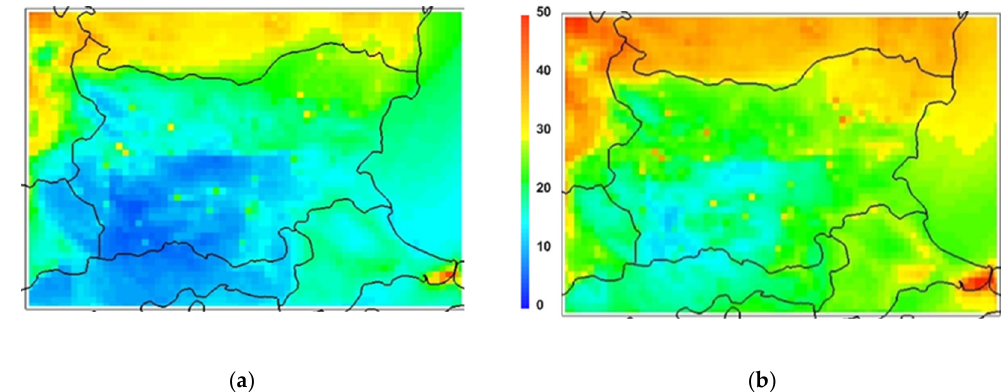
Figure 6. Monthly mean PM 10 in domain Bulgaria value for February 2019; ( a ) from BgCWFS_mod, ( b ) from BgCWFS_sat.